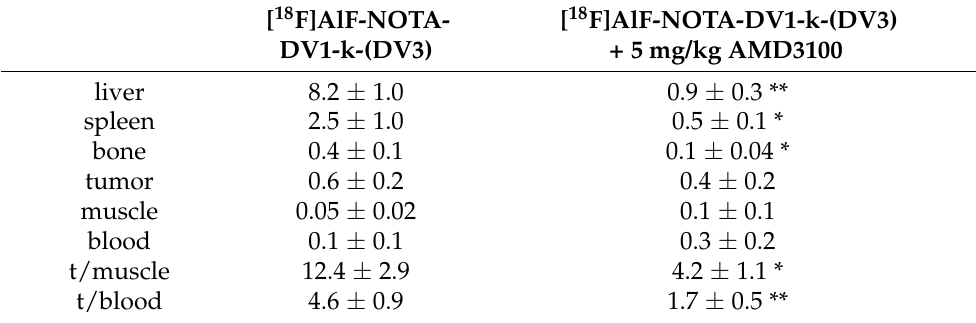
Table 4. Ex vivo biodistribution in U87.hCXCR4 tumor-bearing mice 75 min p.i. (expressed in SUV). Statistical analysis independent-samples t -test. All data are expressed as mean ± SD ( n = 4). * p ≤ 0.01, ** p ≤